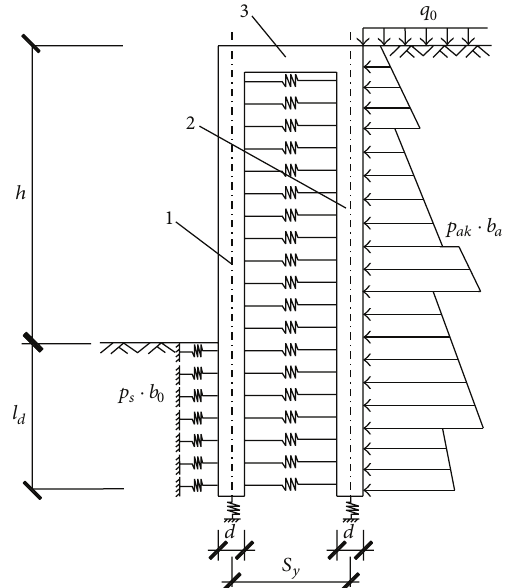
Figure 10: Calculation model of the specification of double-row piles.